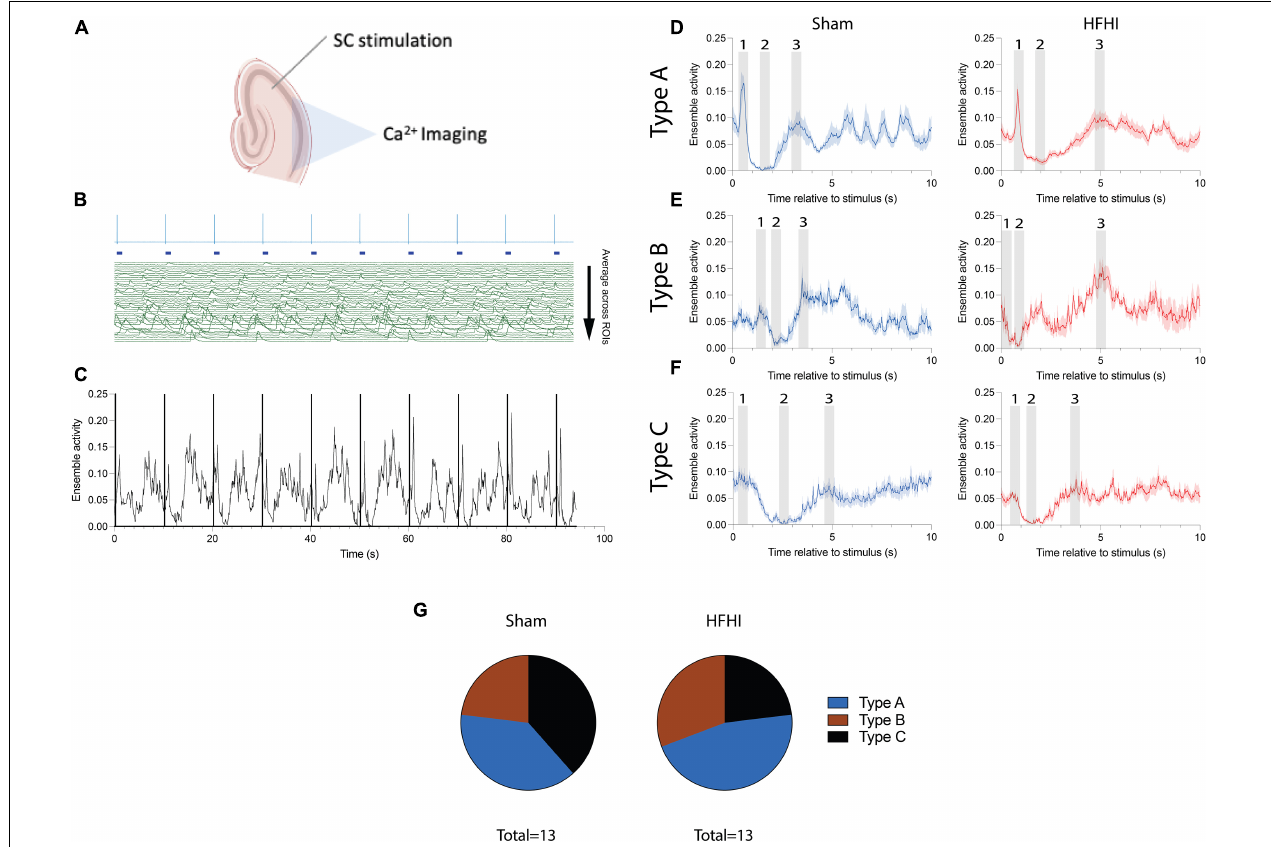
FIGURE 4 | High Frequency Head Impact (HFHI) and sham slices both display distinct ensemble activity following SC stimulation. (A) Acute slices from Thy1-GCaMP6f mice were prepared 24 h following the last day of HFHI and calcium imaging was performed simultaneously with LFP recordings of the CA1 field during an abbreviated LTP paradigm. (B) Example HFHI LFP (top, blue) aligned with raw calcium traces (bottom, green) from one recording. Ensemble activity was obtained by setting individual ROI calcium activity below threshold (4 SD above the baseline) to zero and averaging across all ROIs at each timepoint. (C) Example ensemble activity (black) with stimulus onset overlain (purple) for one session. Calcium ensemble activity following stimulus onset was visualized by binning ensemble activity into 10 s sweeps between stimulus onsets and averaging all the sweeps. We characterized various patterns of post-stimulus ensemble activity generally consisting of (D) a prominent maximum shortly < 1 s after the stimulus (epoch 1), an ensemble minimum 1–3 s following stimulation (epoch 2), and a second ensemble maximum following the minimum (epoch 3) which was usually less prominent although slices from both groups displayed (E) more prominent second maxima or (F) only a transient ensemble inactivation with no maxima. (G) Pie charts showing distribution of patterns classified into Type A (1st maximum and ensemble minimum), Type B (2nd maximum an ensemble minimum), and Type C (ensemble minimum only). Shaded regions represent mean ± SEM across 9 sweeps in line